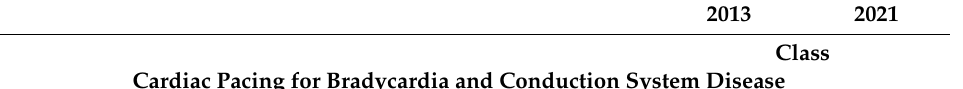
2013 2021 Class